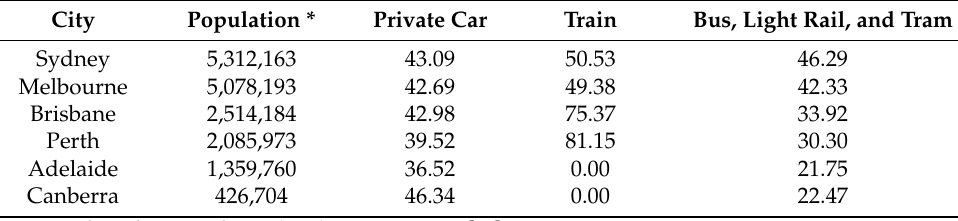
Table 3. City populations [55] and daily passenger kilometre travel (km d − 1 ) per employee [54]. City Population * Private Car Train Bus, Light Rail, and